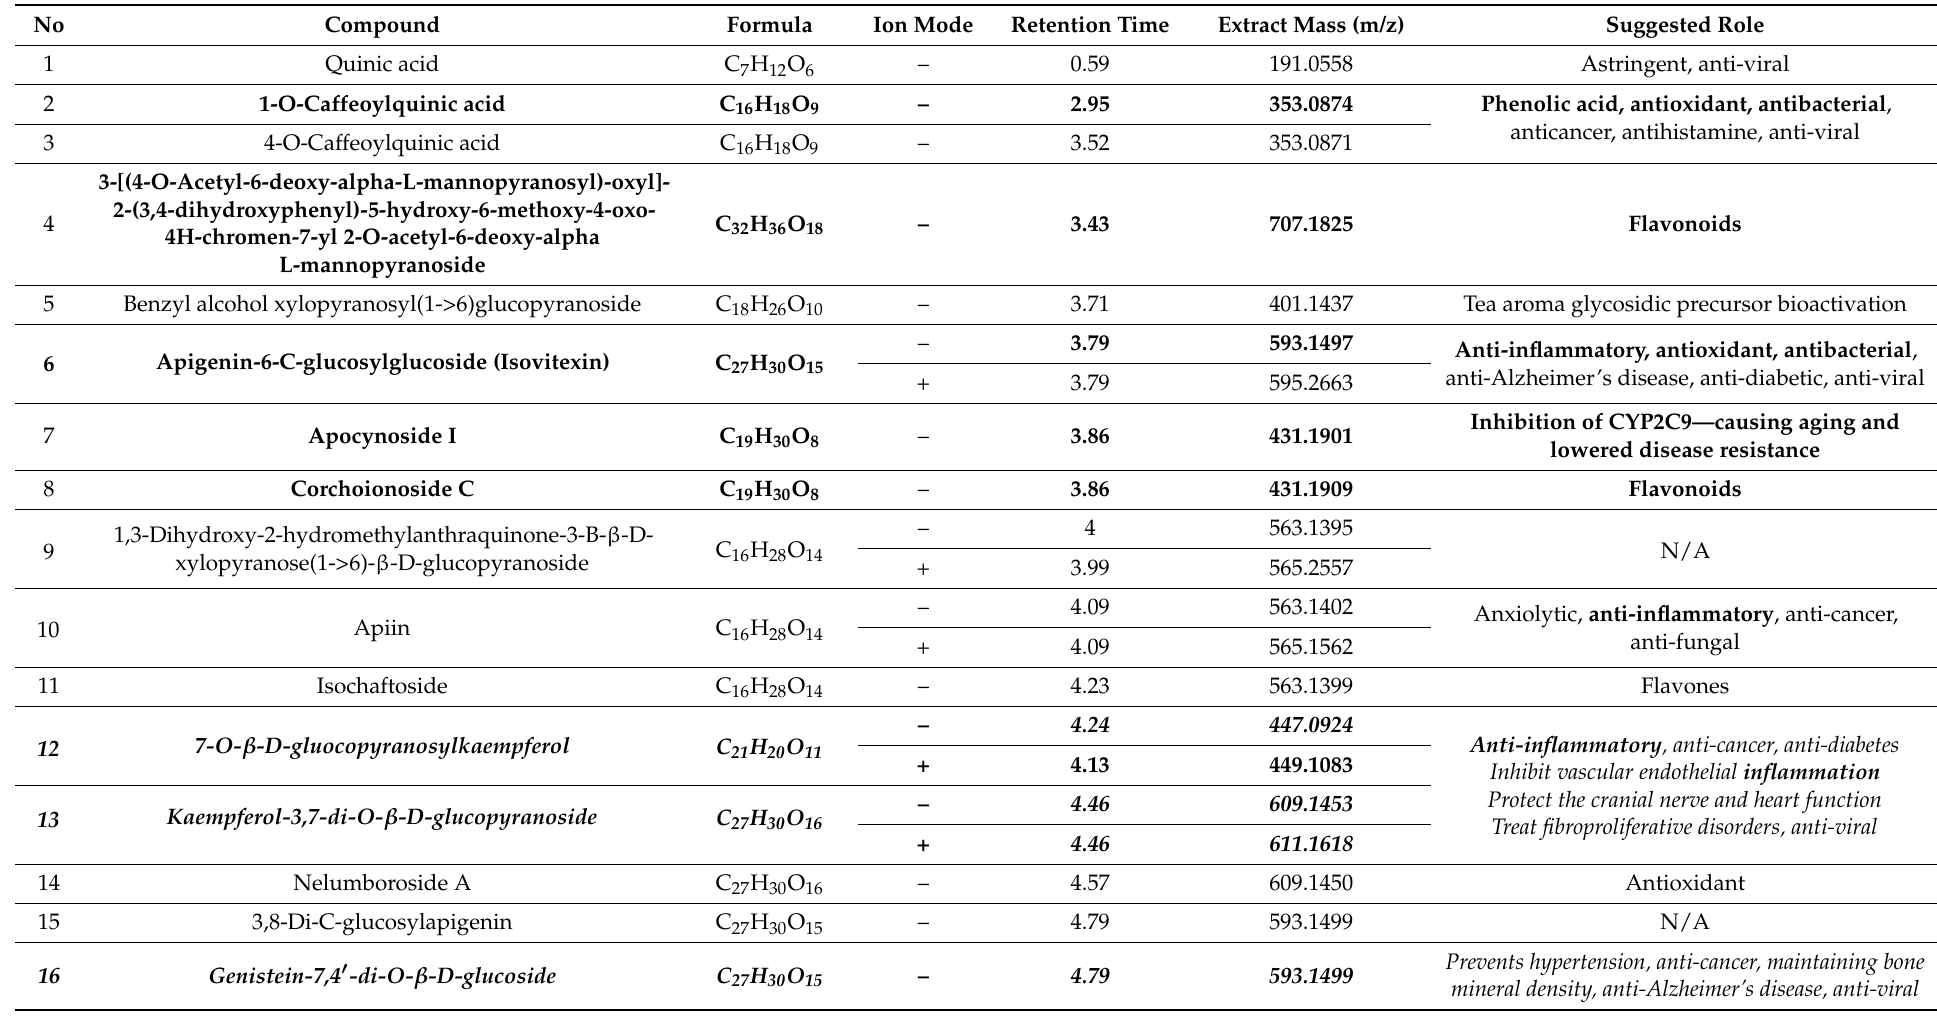
Table 1. Identified compounds in